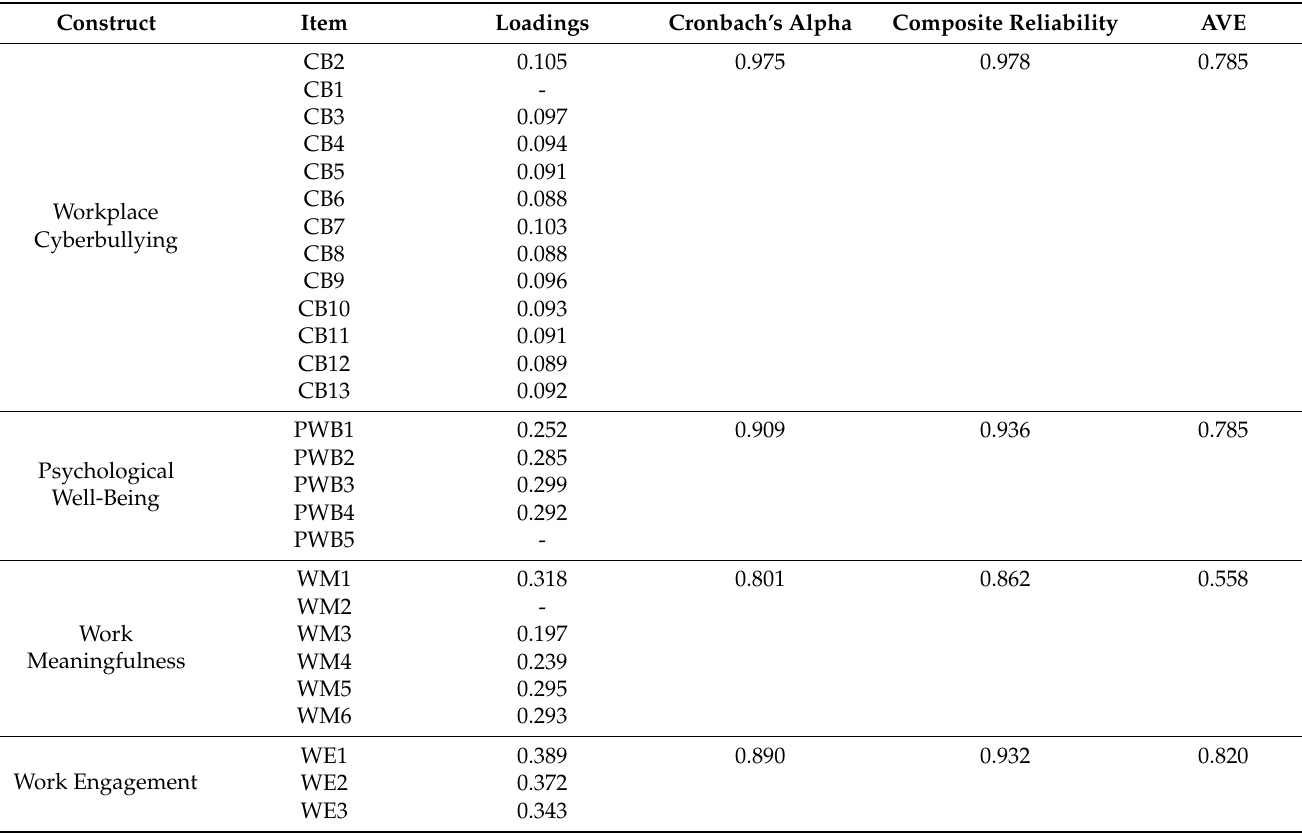
Table 1. Factor loading and validity.